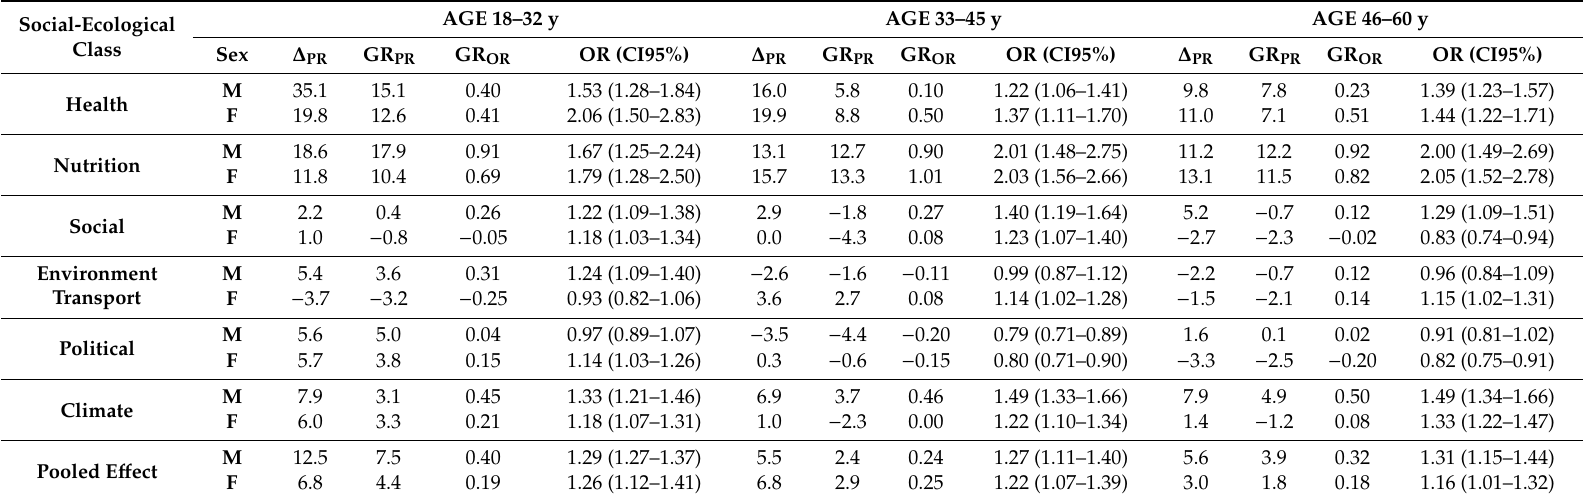
Table 3. E ff ects of exposure to social-ecological classes of variables on the prevalence and odds ratio of physical activity ( > 150 min / week) in Brazilian adults by sex and age